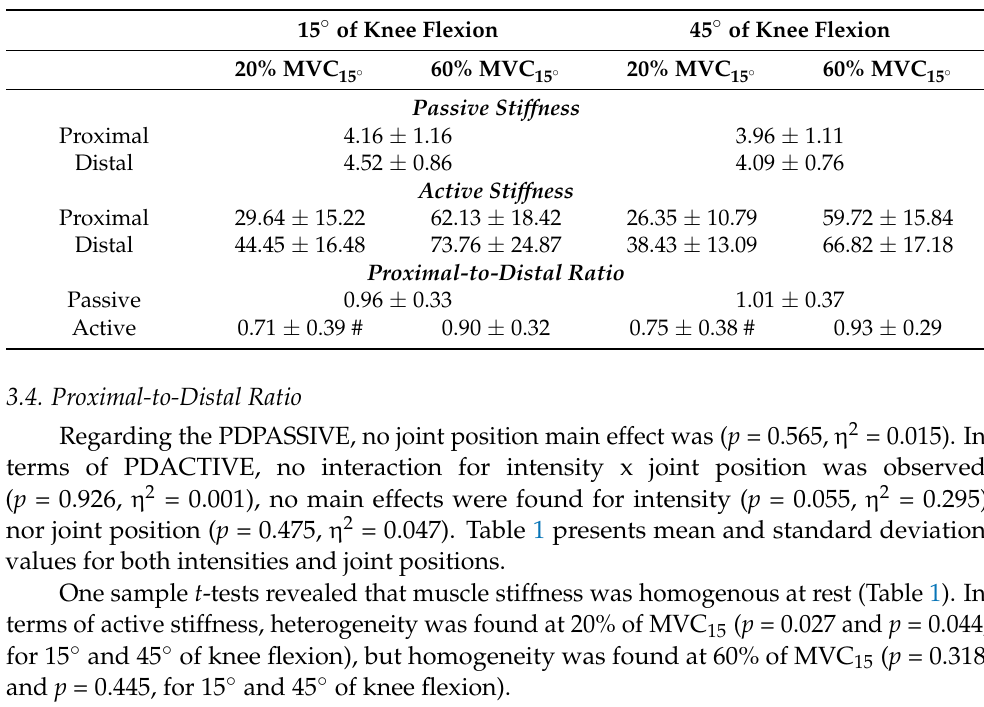
Table 1. Biceps femoris long head passive and active stiffness in both regions (proximal and distal) across the different conditions, and its proximal-to-distal ratio. Note that for passive stiffness, there was no intensity factor, since it was measure during passive, at rest, condition. All data are presented as mean ± standard deviation. # indicates statistically difference from 1 ( p <